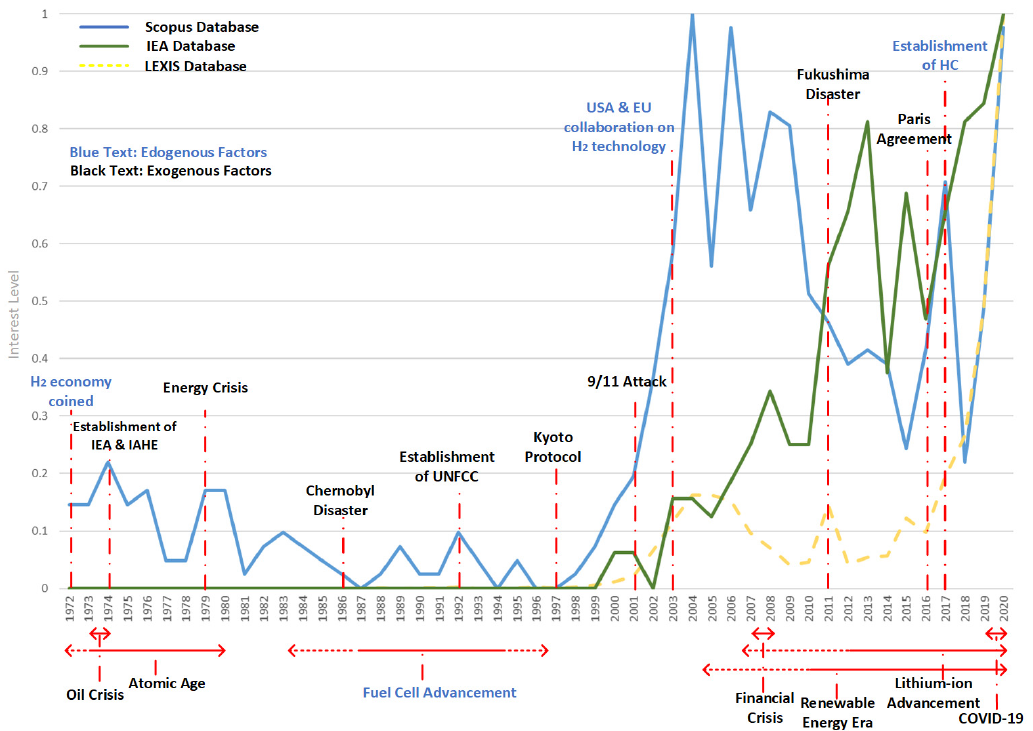
Figure 7. Normalized annual publications in selected literature.